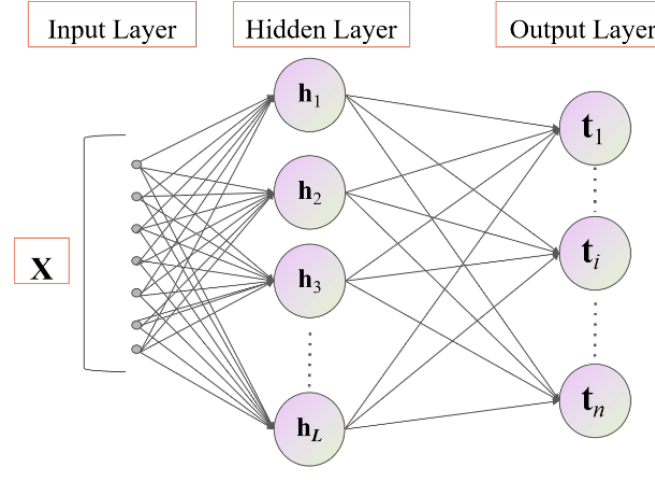
Figure 1. The structure of SLFNs. Figure 1. The structure of SLFNs. N The ELM algorithm reduces the training parameters by randomly initializing the ( )   , = S x t , where   , ,..... m x x R =  x is the With a training sample i i i = 1 2 i i i im 1 parameters of hidden layer nodes so that the network between the input and hidden layers , ,..... n t t t R =  t is the i th target vector. SLFNs with L hid- i th input vector, and   becomes a fixed nonlinear transformation. After the fixed nonlinear transformation of the 1 2 i i i in hidden layer, the input parameters are mapped to a new linear space named the ELM den nodes can be described as Equation (1). feature space [24]. The ELM trains the network by minimizing the estimated and actual values error. Thus, the objective loss function of the model is shown as follows: ( ) m R  x  is the output weight coefficient where is the input parameter of the SLFNs, i where connecting the hidden layer and the output layer, are the randomly generated node parameters of the hidden layer. The ELM algorithm reduces the training parameters by randomly initializing the pa- is the hidden nodes output matrix, β = [ β 1 , β 2 . . . , β L ] T , and T = [ t 1 , t 2 . . . , t N ] T . rameters of hidden layer nodes so that the network between the input and hidden layers becomes a fixed nonlinear transformation. After the fixed nonlinear transformation of the hidden layer, the input parameters are mapped to a new linear space named the ELM feature space [24]. The ELM trains the network by minimizing the estimated and actual values error. Thus, the objective loss function of the model is shown as follows: